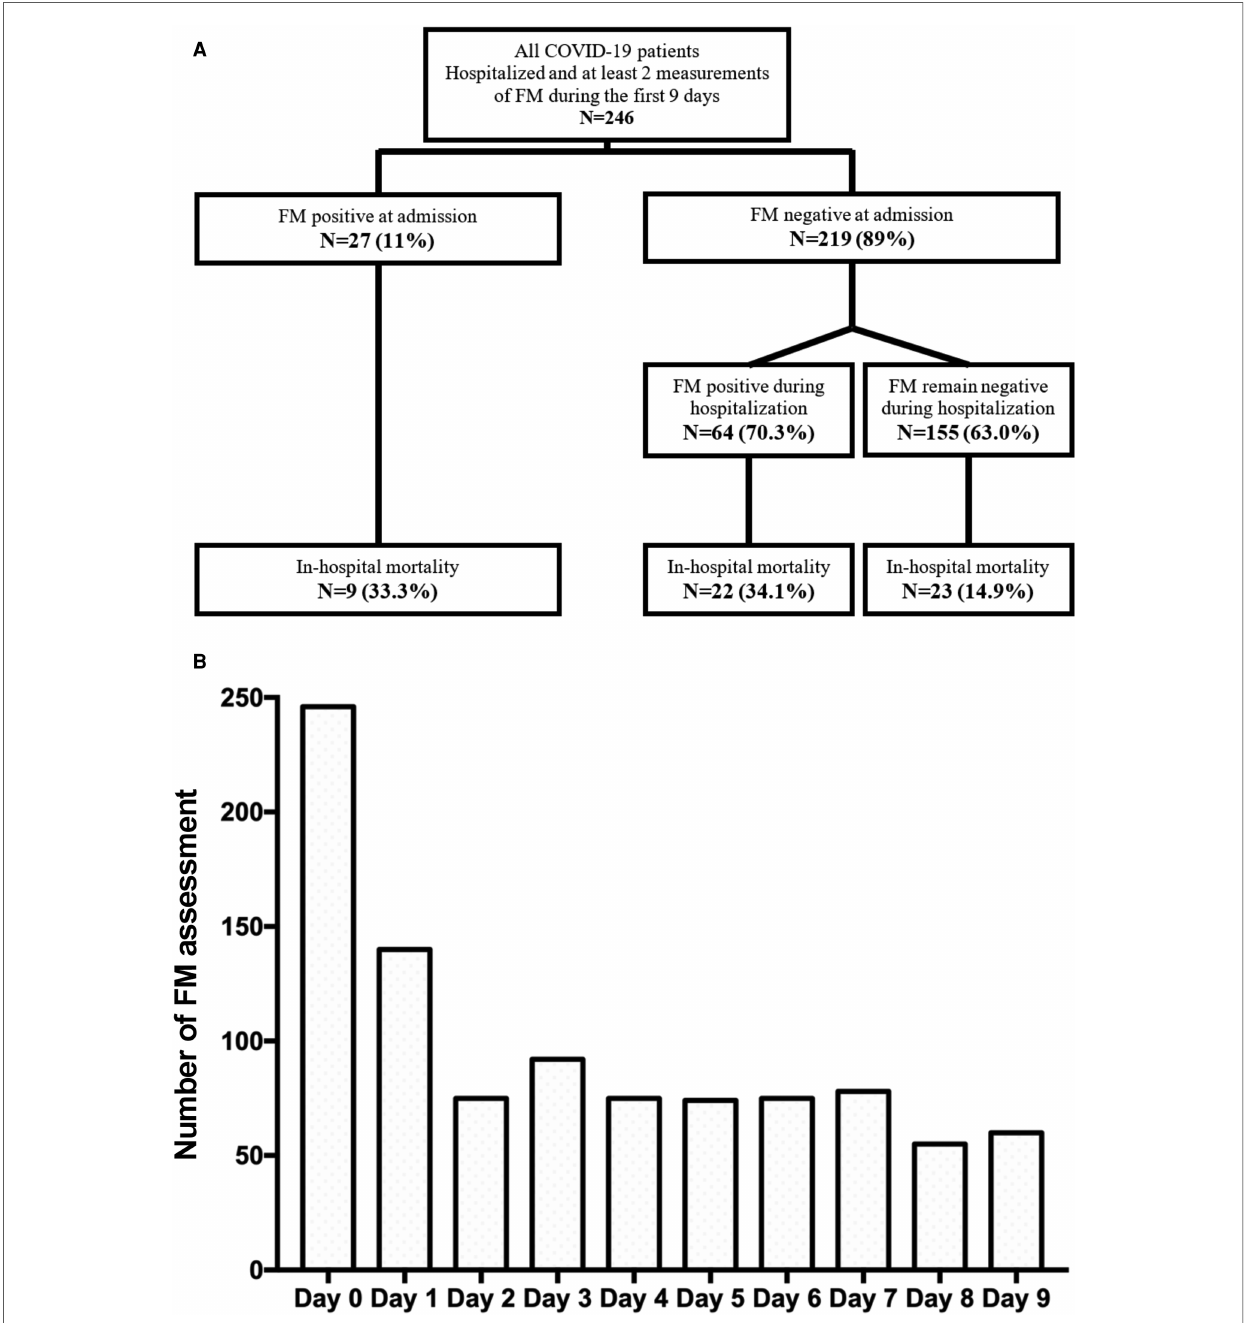
FIGURE 1 Population description. ( A ) Study fl ow chart. We solely included patients who had been hospitalized and whose FM levels had been measured at least twice during the fi rst 9 days of hospitalization. We excluded all patients who did not meet these criteria. ( B ) Number of FM level